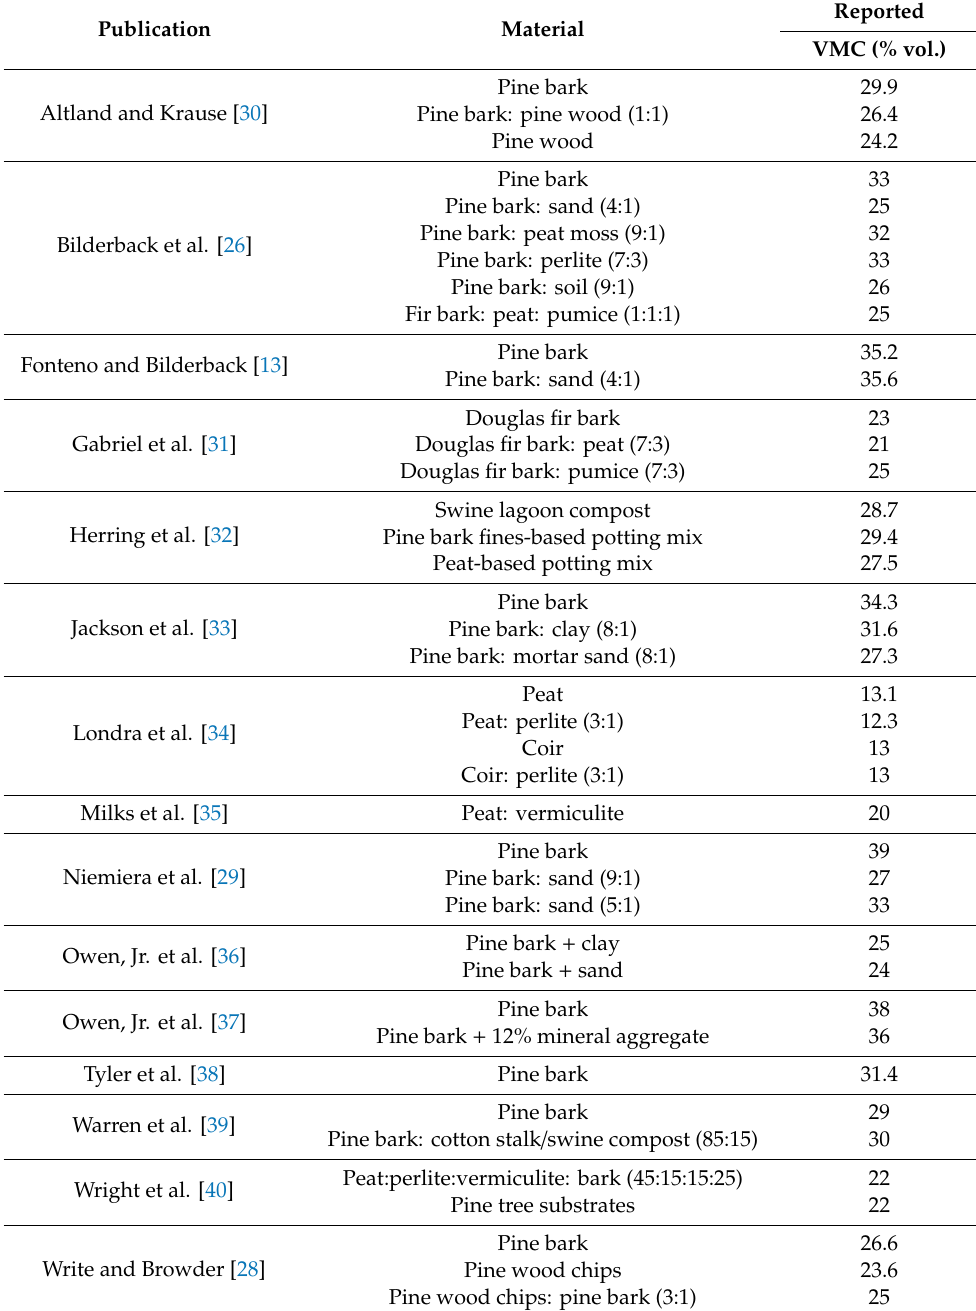
Table 2. Survey of soilless substrate VWC at substrate water potentials of − 1.5 MPa as measured through pressure plate